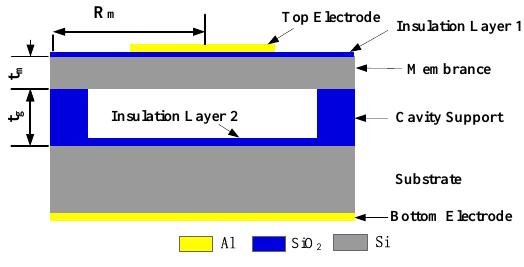
Figure 1. The structure of a cell.